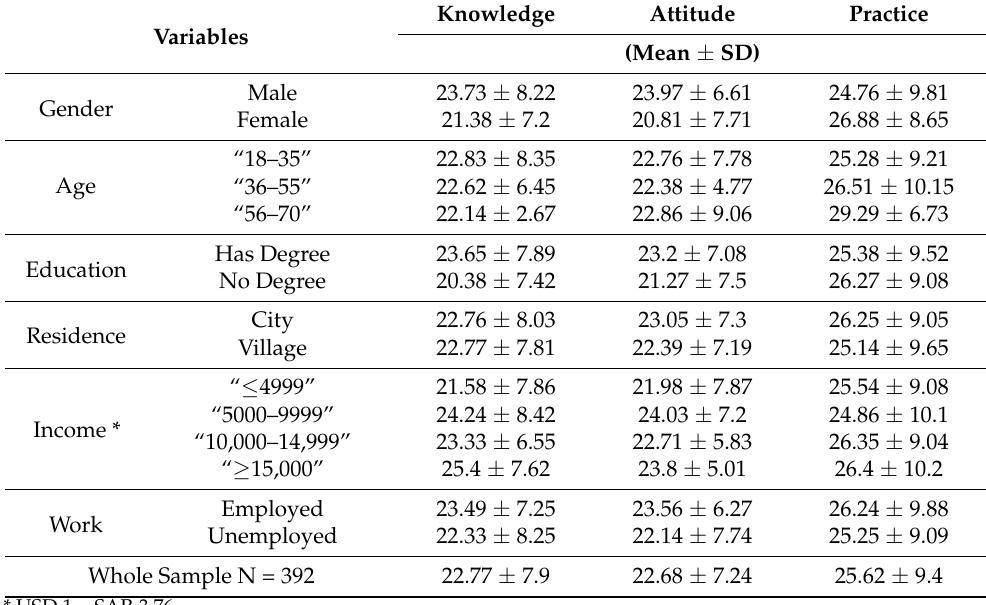
Table 2. Knowledge, attitude, and practice scores of the participants in the sample.